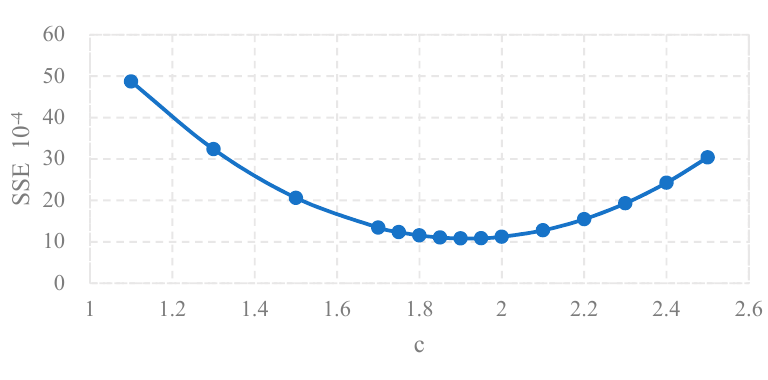
Figure 10. The SSE vs. c. The total-to-total efficiency can be predicted by the loss models and Equation